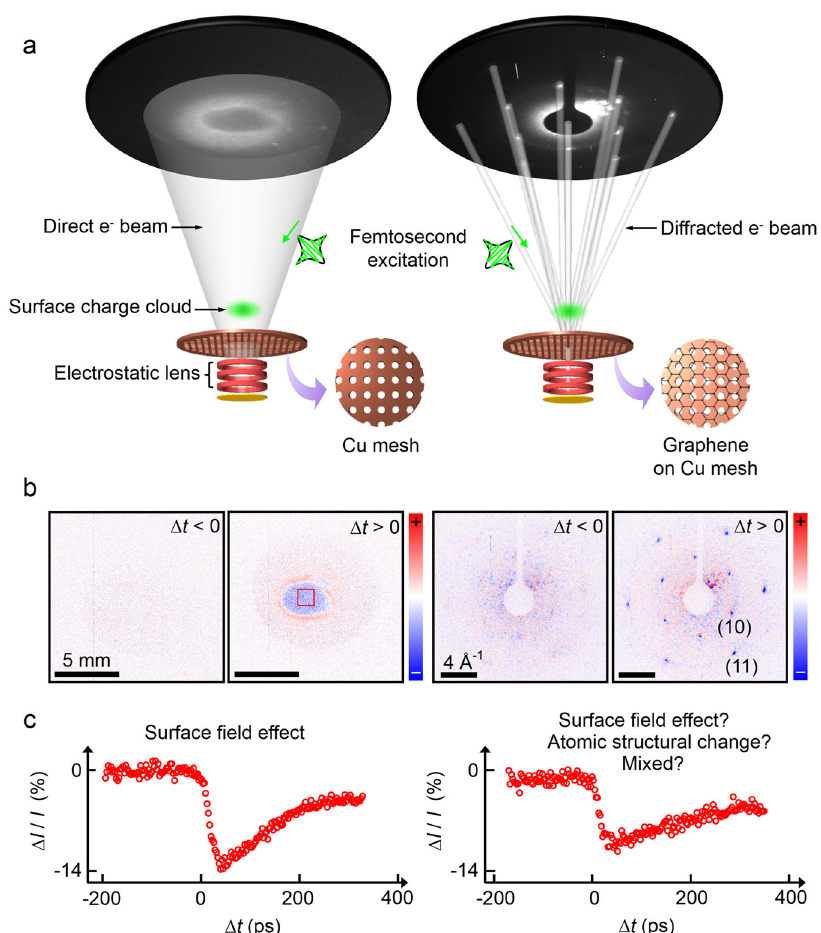
Fig. 1 Conceptual illustration of the study of the surface fi eld effect on ultrafast low-energy electrons. a Schematic of the experimental layout. A femtosecond laser excitation pulse is incident either on a standard TEM copper mesh grid or on freestanding monolayer graphene suspended on the same type of the grid. Upon photoexcitation, a divergent direct ultrafast low-energy electron beam forms a projection image of the copper grid at the screen (left panel), while a low-energy electron beam focused by an electrostatic Einzel lens integrated into the photocathode produces a graphene diffraction image (right panel). The images are recorded as a function of the delay time, Δ t , between the excitation pulse and the electron beam. b Typical example of the difference map (a “ static ” image without excitation subtracted from a time-resolved image with excitation) before ( Δ t = 0) and after ( Δ t = 50 ps) excitation. The left and right pairs of maps correspond to the direct and diffracted beam case, respectively. The color bars indicate pixel intensity variations ( Δ I ) of the maps. c Time trace of the relative intensity difference ( Δ I / I ) measured at the regions-of-interest (ROI) indicated by the red box in b (left panel), and at the (10) diffraction spots (right panel, average of six spots). Each measurement condition for panels b and c is ( F = 22.8 mJ cm − 2 , D = 550 fs), and ( F = 12.1 mJ cm − 2 , D = 500